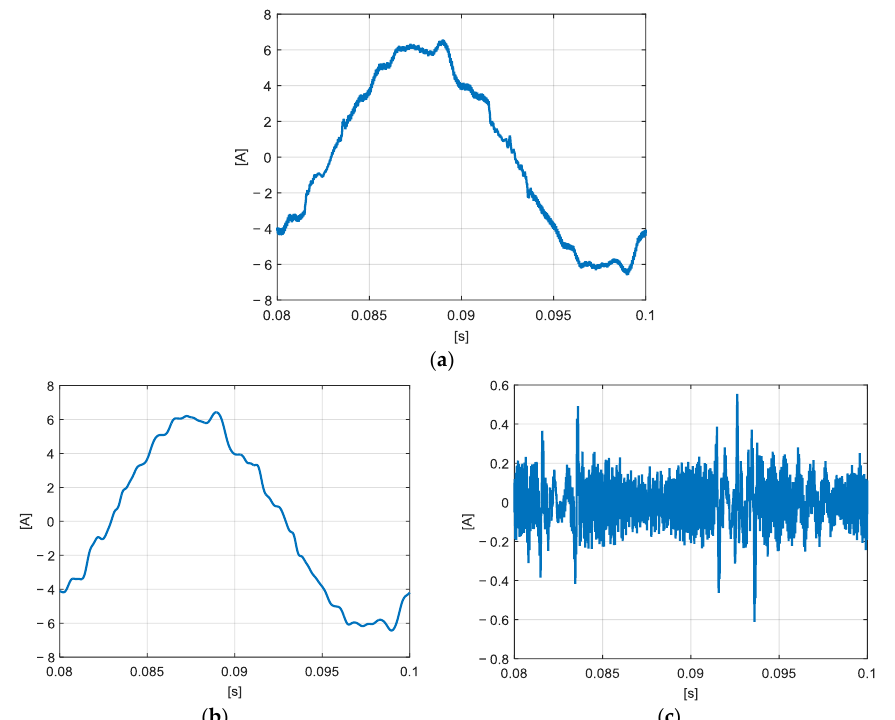
Figure 10. Case study 2: time trend of the waveform under study in terms of ( a ) original waveform, ( b ) low-frequency waveform and ( c ) high-frequency waveform.